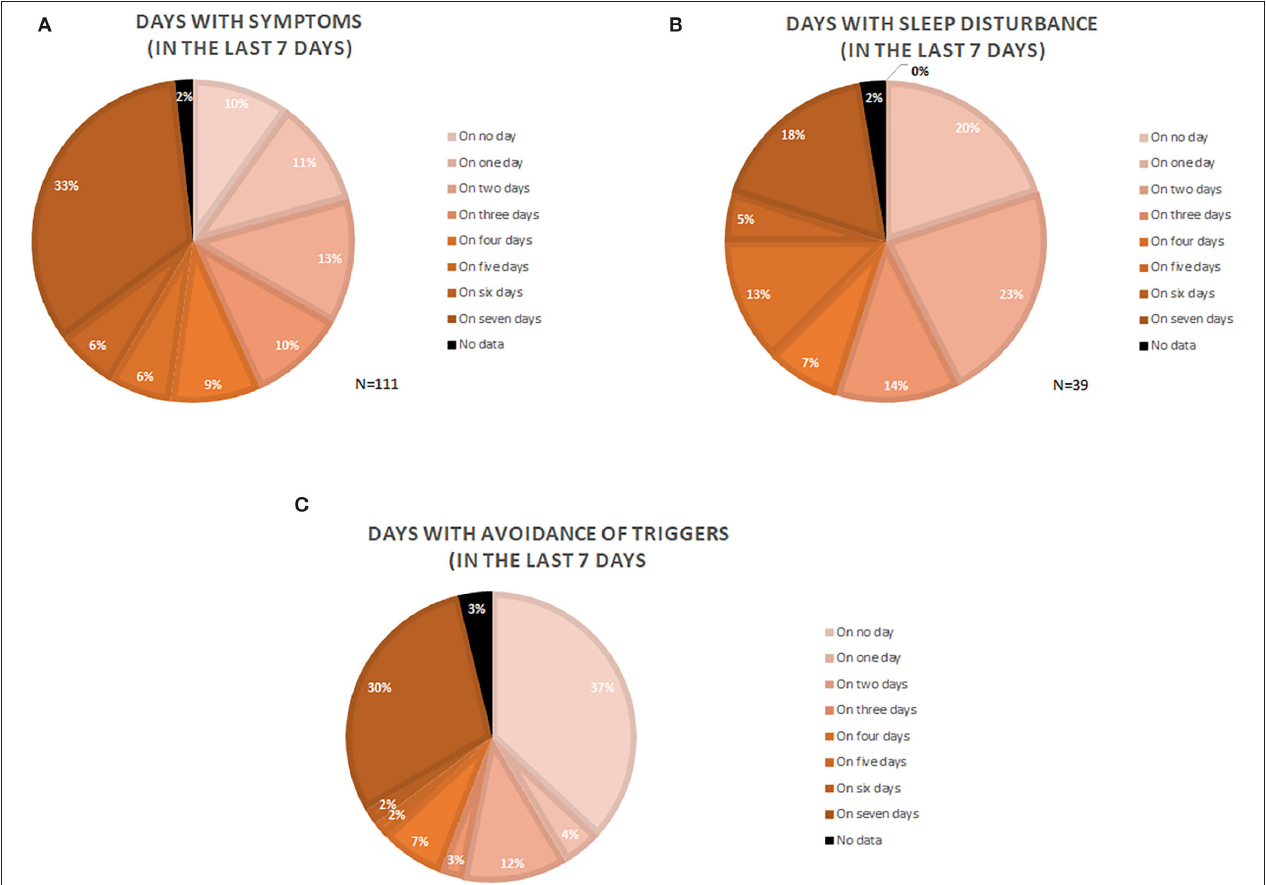
FIGURE 1 | Depiction of symptomatic days (A) , days with sleep disturbance (B) , and days where patients actively avoided trigger situations (C) . Numbers are given as the percentage of the analyzed patients ( N = number of patients).